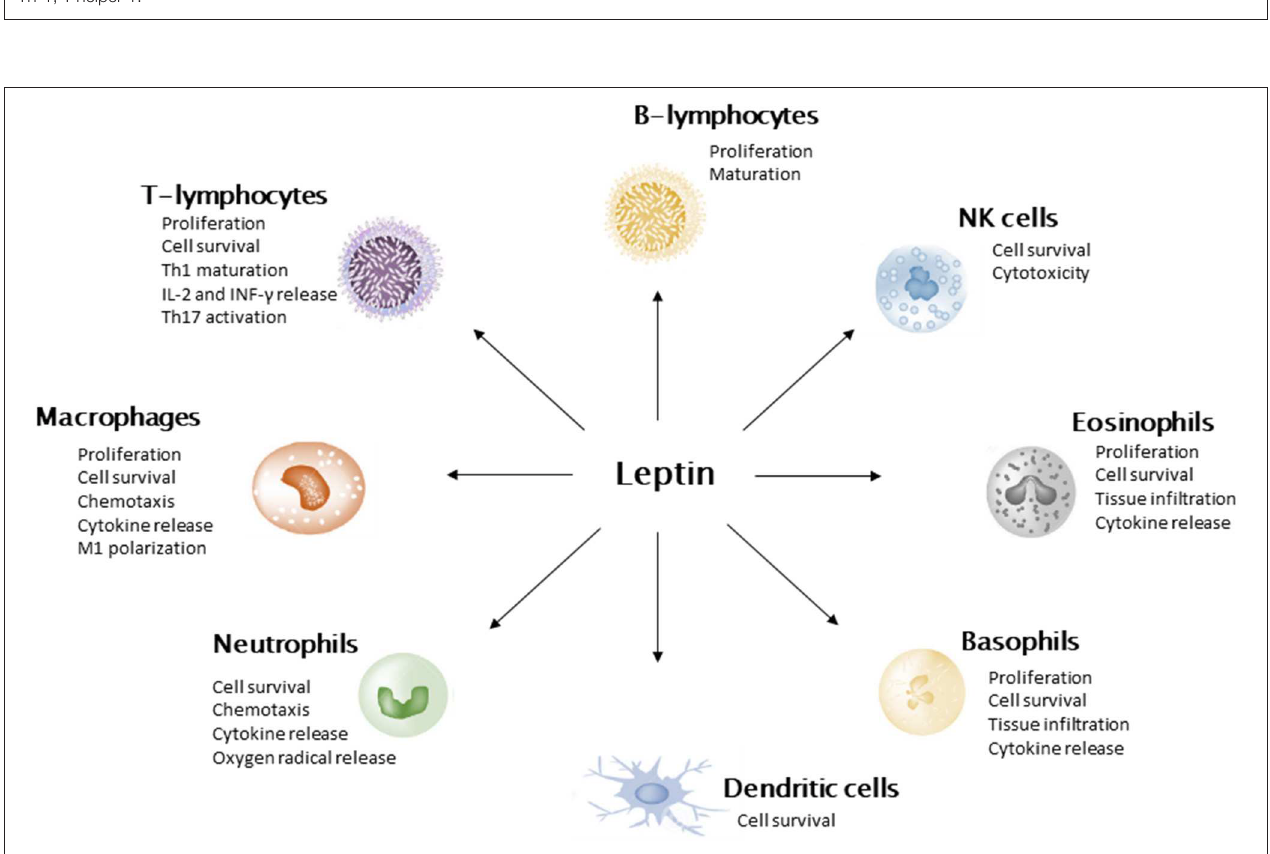
FIGURE 2 | Leptin action on immune cells. Leptin promotes cell survival, stimulates the secretion of pro-inflammatory cytokines, and suppresses cell apoptosis. It induces M1 polarization of macrophages and stimulates Th1 pathway in T-lymphocytes.